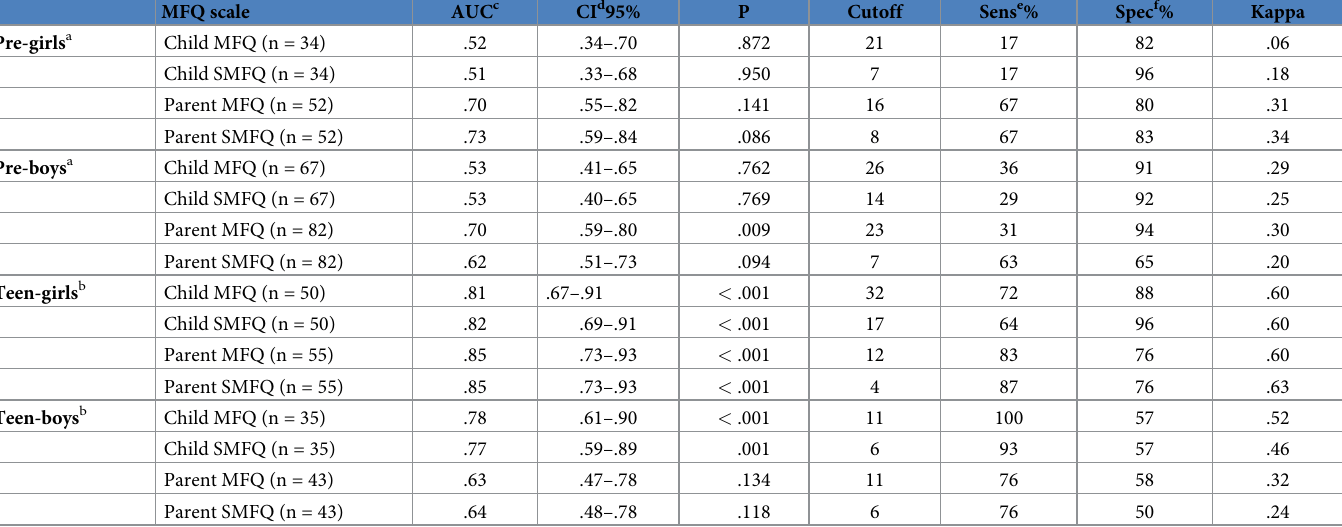
Table 2. Psychometric properties of the Mood and Feelings Questionnaire (MFQ) and Short Mood and Feelings Questionnaire (SMFQ) for the child and parent rat- ings versus the criterion test with Longitudinal Expert All Data diagnoses of DSM-IV